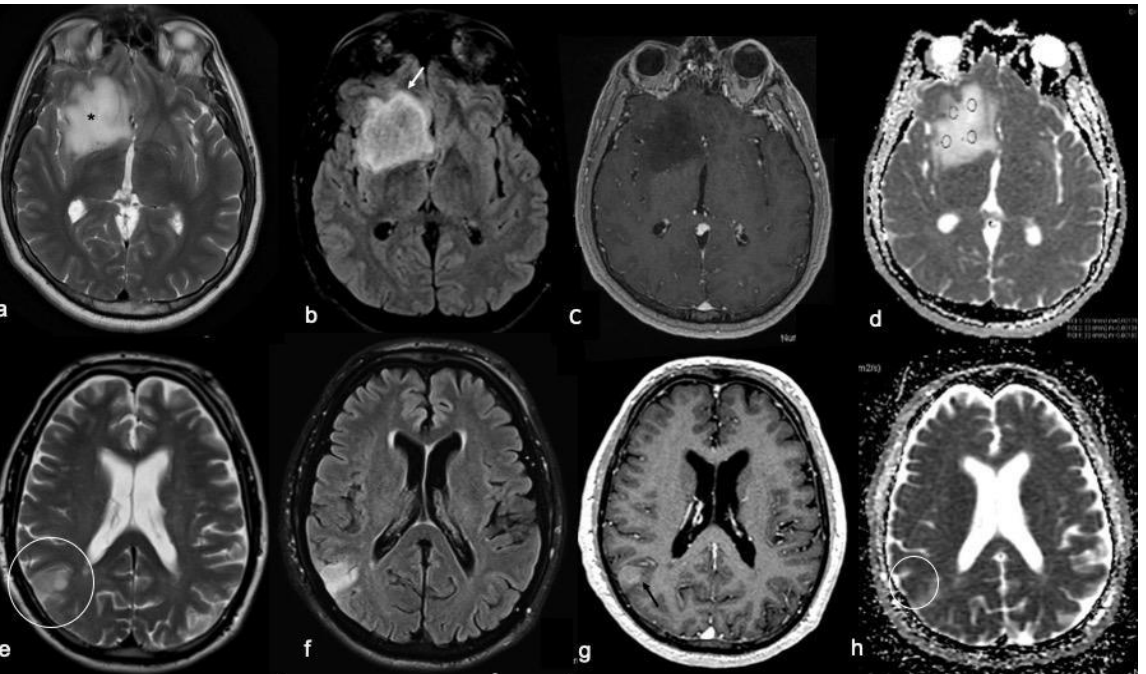
Figure 1. Radiological characteristics of IDH-MUT (top row: ( a – d )) and IDH-WT (bottom row: ( e – h )) diffuse gliomas. For each case, T2w fast spin echo ( a , e ), FLAIR sequences ( b , f ), T1w fast spin echo contrast-enhanced ( c , g ), and ADC map ( d , h ) images are shown. ( a – d ) Right frontal tumor with defined borders, a high and homogeneous T2w signal (asterisk in ( a )), a T2w/FLAIR mismatch sign (arrow in ( b )), no contrast enhancement, and high ADC values; these are the typical imaging findings of an IDH-MUT glioma. ( e – h ) Right parietal ill-defined tumor (inside the circle in ( e , h )) characterized by a low T2w signal ( e ), no evidence of a T2w/FLAIR mismatch sign ( f ), a slight contrast enhancement ( g ), and a low signal in the ADC maps; these imaging findings are typical of an IDH-WT glioma. Considering tumors with IDH-MUT and 1p/19q codeletion, most are located in the frontal lobes and cortex [25] and the anterior extensions of the lateral ventricles compared to IDH-WT